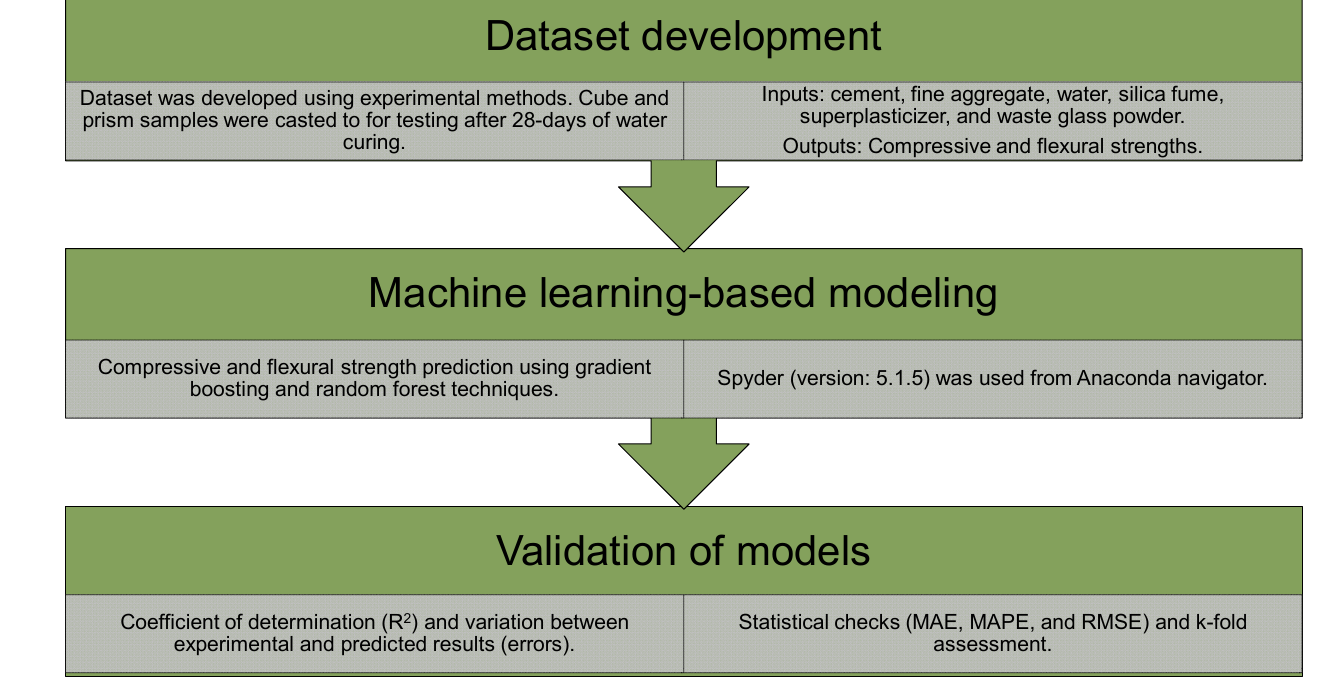
Figure 2. Sequence of dataset development, modeling, and validation methods.